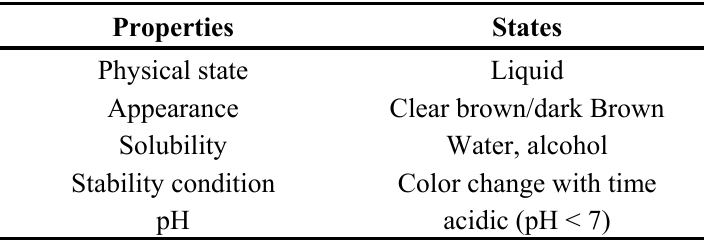
Table 1. Summary of some observed properties of the extract from fermented nopal